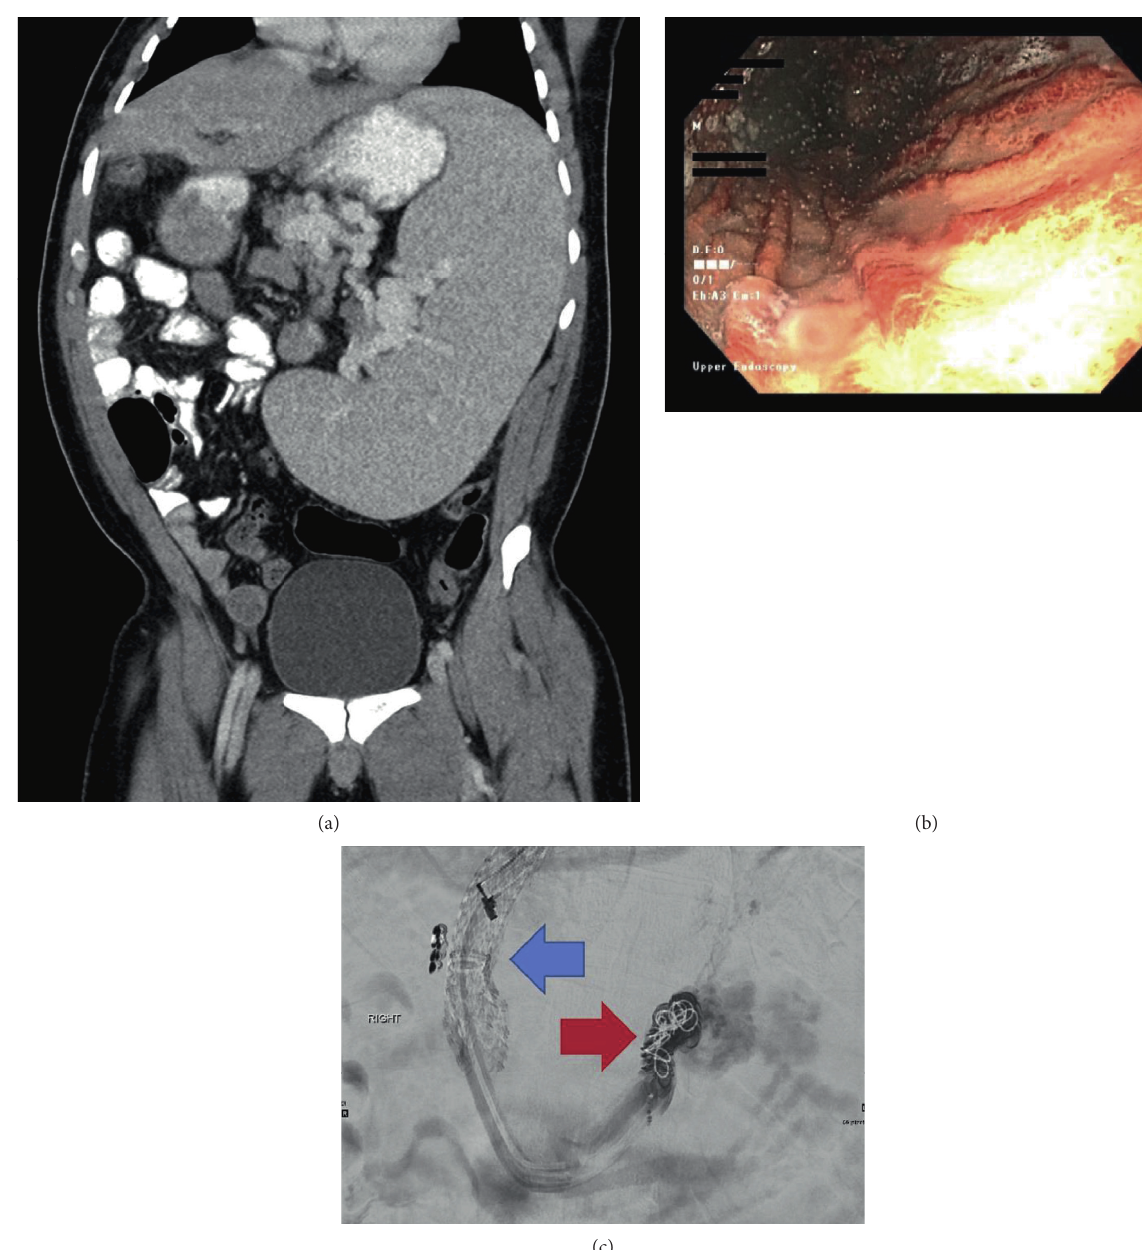
Figure 1: (a) Non-contrast-enhanced CT scan of the abdomen and pelvis showing splenomegaly with a craniocaudal length of 23cm and portosystemic collaterals. (b) Endoscopic image of the stomach showing diffuse portal gastropathy. (c) Fluoroscopic image following TIPS placement (blue arrow) and coiling of the bleeding esophageal varix (red